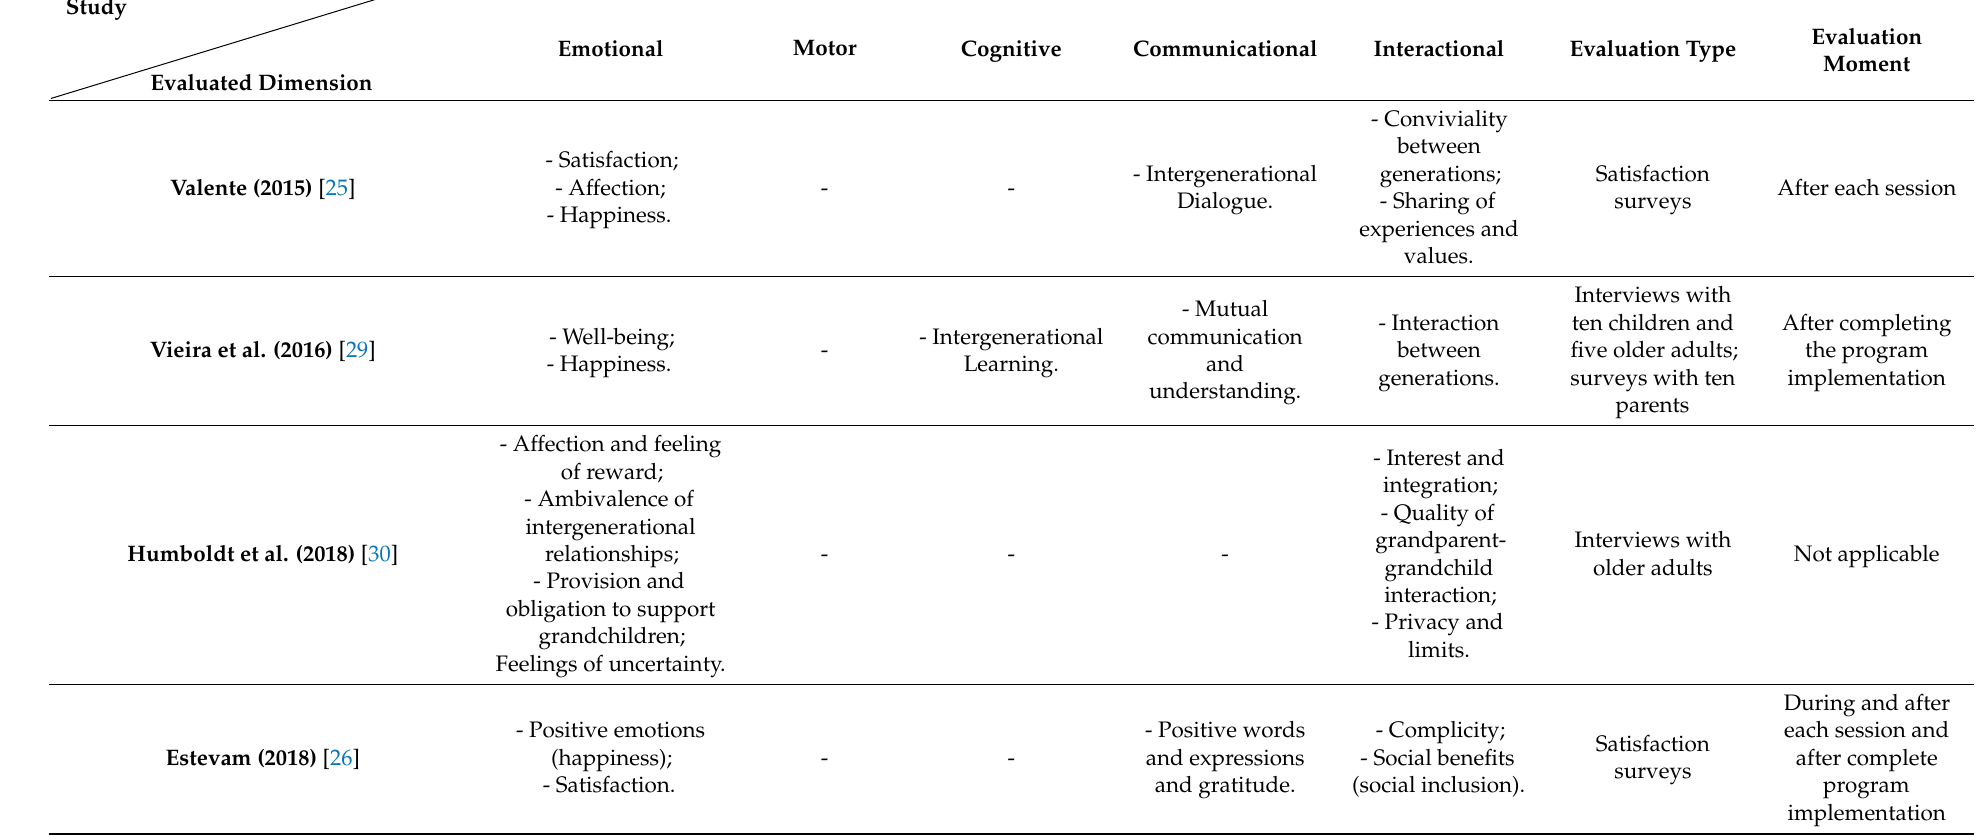
Table 4. Categories of evaluated dimensions in the applied